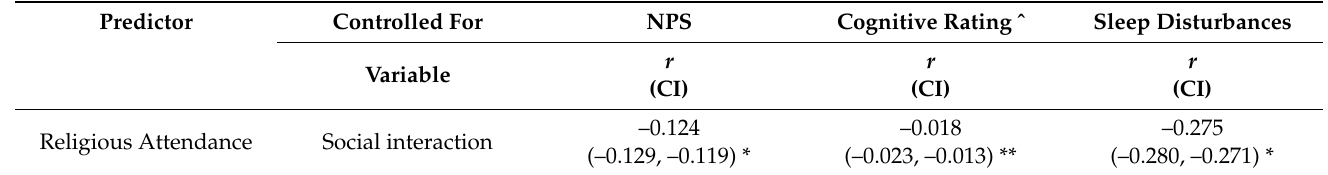
Table 4. Correlation Analysis